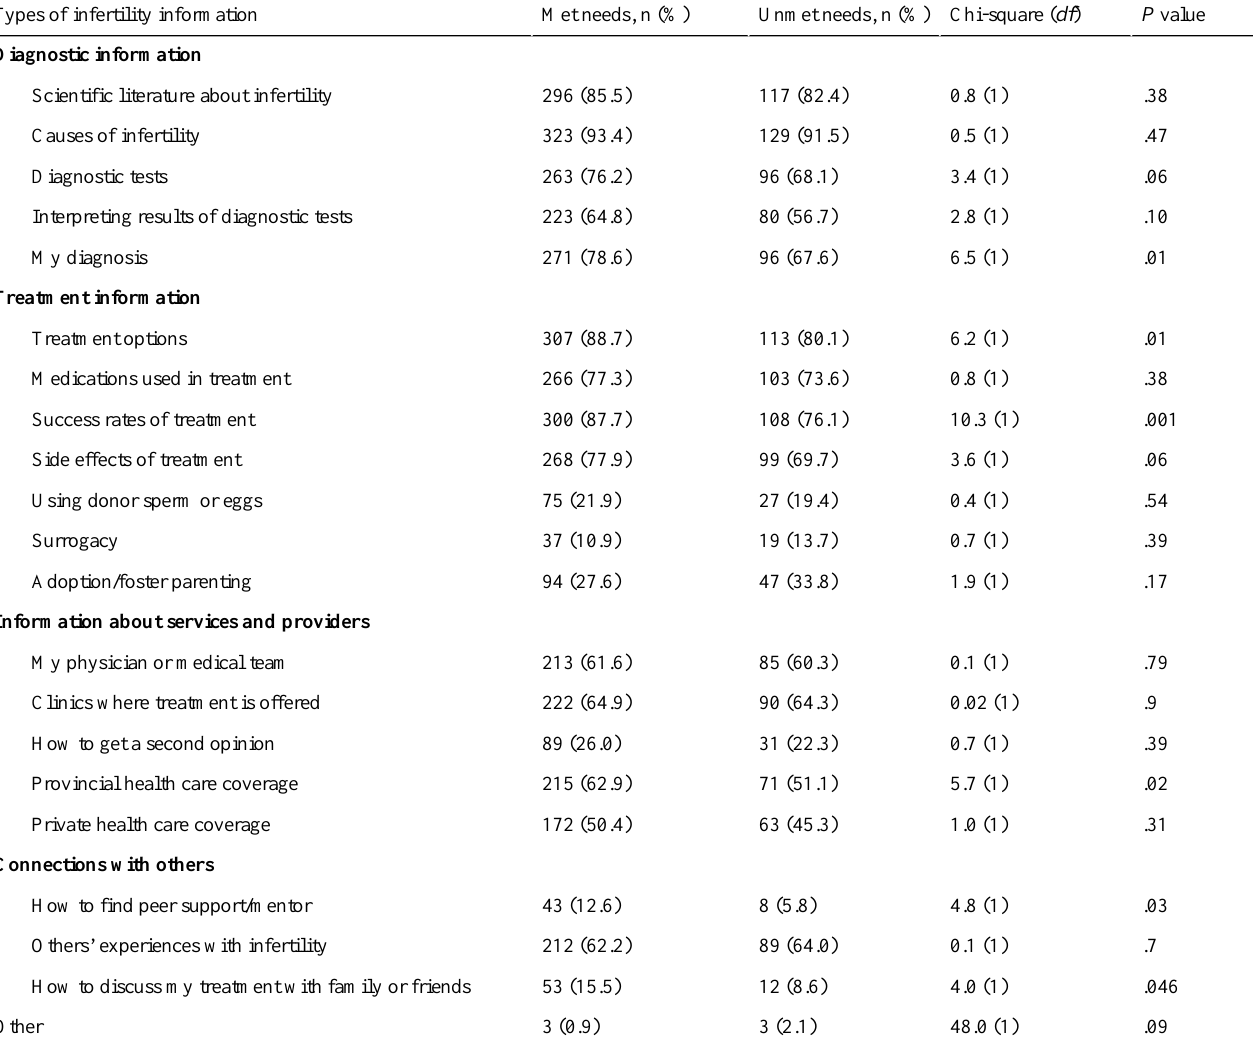
Table 4. Comparison of topics searched by participants reporting met (n=346) and unmet (n=142)